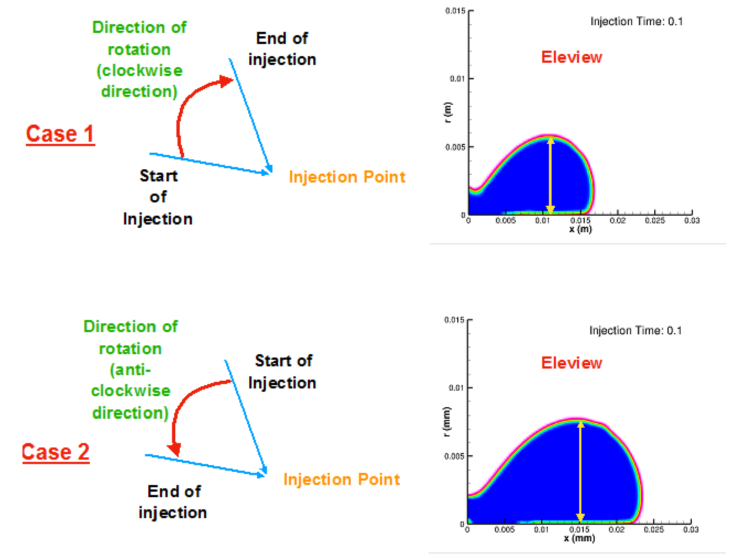
Figure 4. Comparison of polyp formation in dynamic